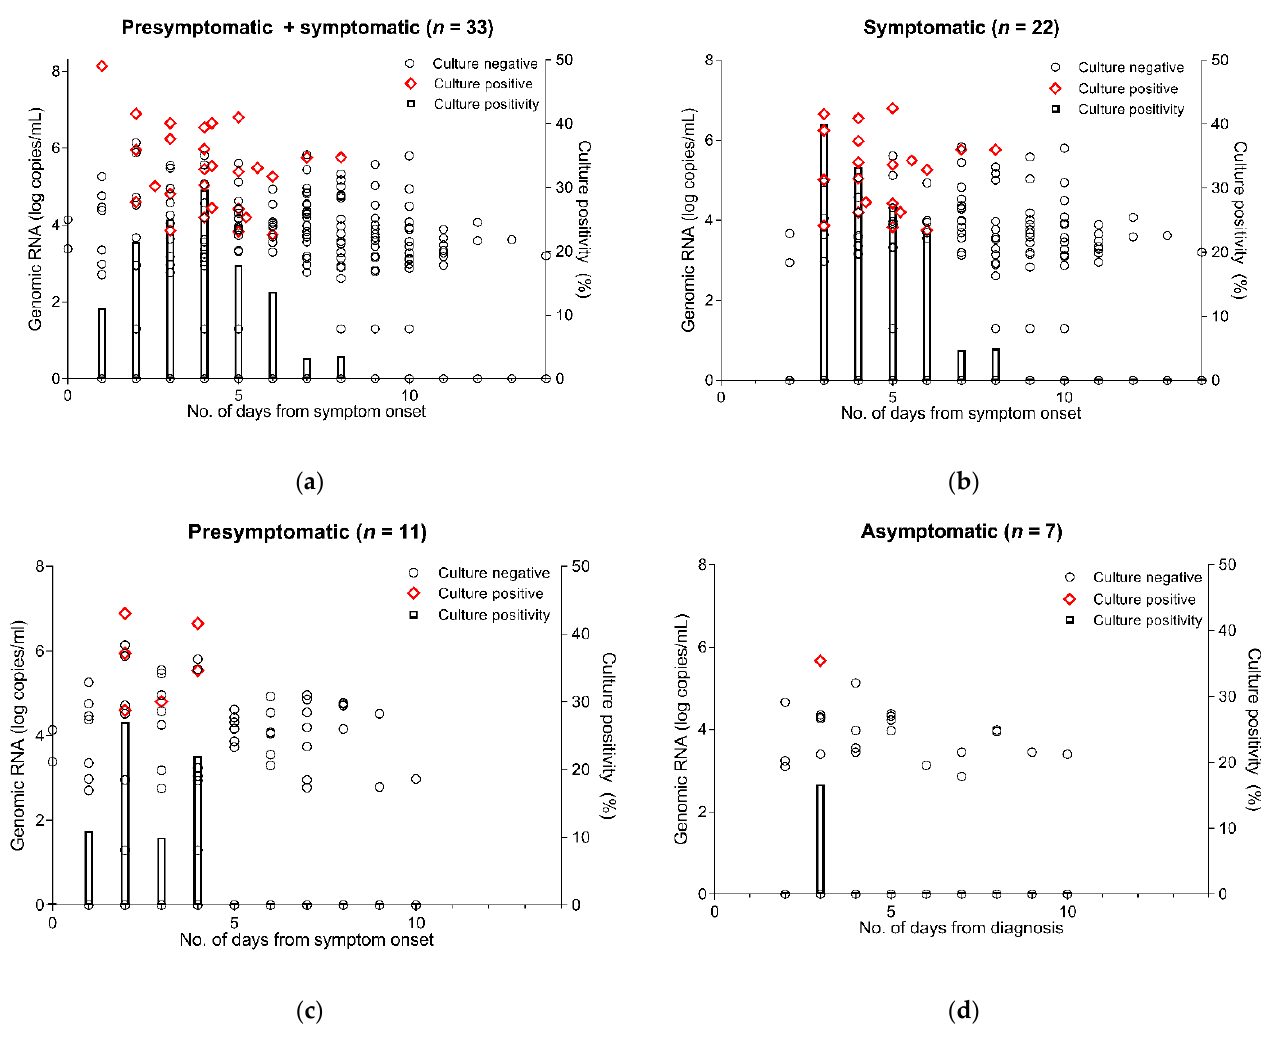
Figure 4. Results of cell culture for SARS-CoV-2. Red-colored dots indicate positive cell culture. The subgenomic positive (red) is plotted as the genomic copy number in a sample (left y -axis), where subgenomic RNA was also detected. The subgenomic negative (black) is plotted as the genomic copy number in a sample (left y -axis), where no subgenomic RNA was detected. The subgenomic positivity (right y -axis) indicates the percentage of subgenomic RNA positive samples among the total samples by the day. ( a ) Presymptomatic + symptomatic. ( b ) Symptomatic. ( c ) Presymptomatic. ( d ) Asymptomatic.